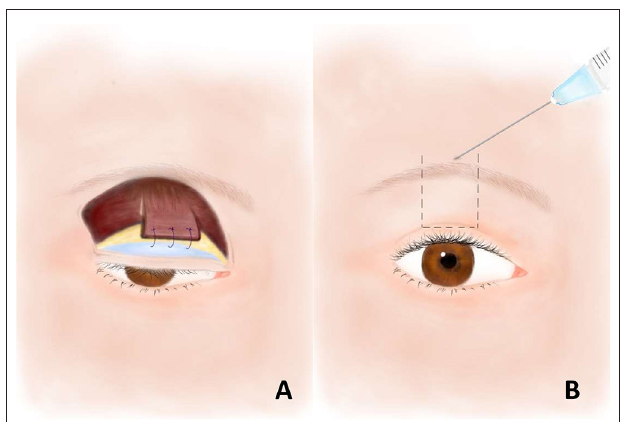
FIGURE 1 | (A) The frontalis-orbicularis oculi muscle (FOOM) flap with the vertically oriented frontalis muscle at the upper part and the horizontally oriented orbicularis oculi muscle at the lower part. The flap is sutured to the upper tarsus after shortened to the desired length. (B) Botulinum toxin-A injection at the central supra-brow area, the origin of the FOOM flap. The area within the dashed lines represents the presumed location of the underlying FOOM